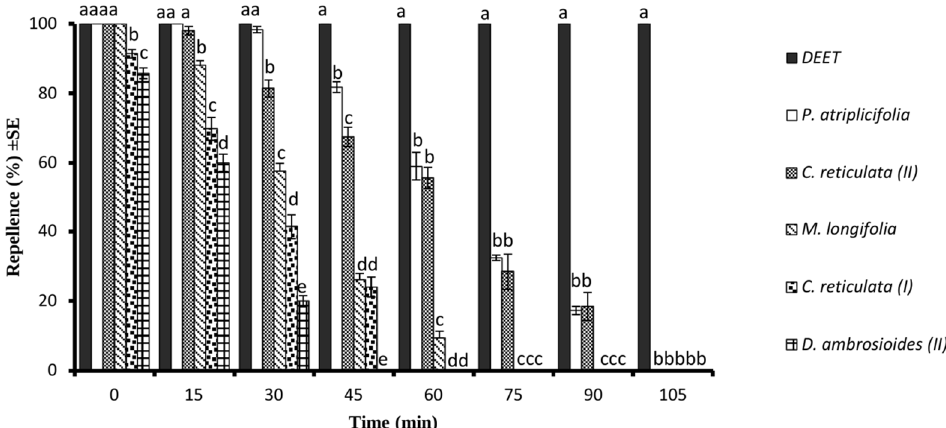
Figure 3. Time span of mosquito repellent effect of different essential oils and DEET at the tested dose of 165 µ g/cm 2 against Ae. aegypti females. Different letters on the bars show a significant difference ( p < 0.05) among different test substances at a specific period. Error bars on each column represent standard error where n = 5.